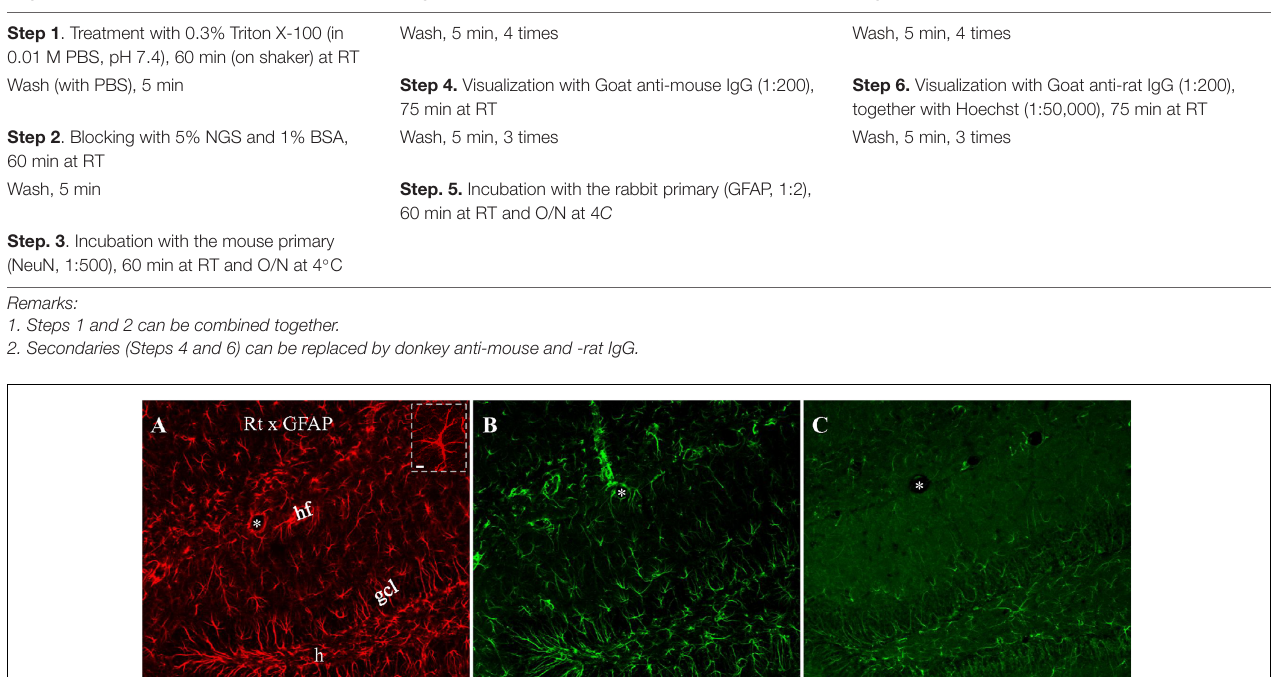
TABLE 2 | Step by step protocol for sequential staining to avoid cross immunoreactivity using both mouse and rat primary antibodies. Day 1 Day 2 Day 3